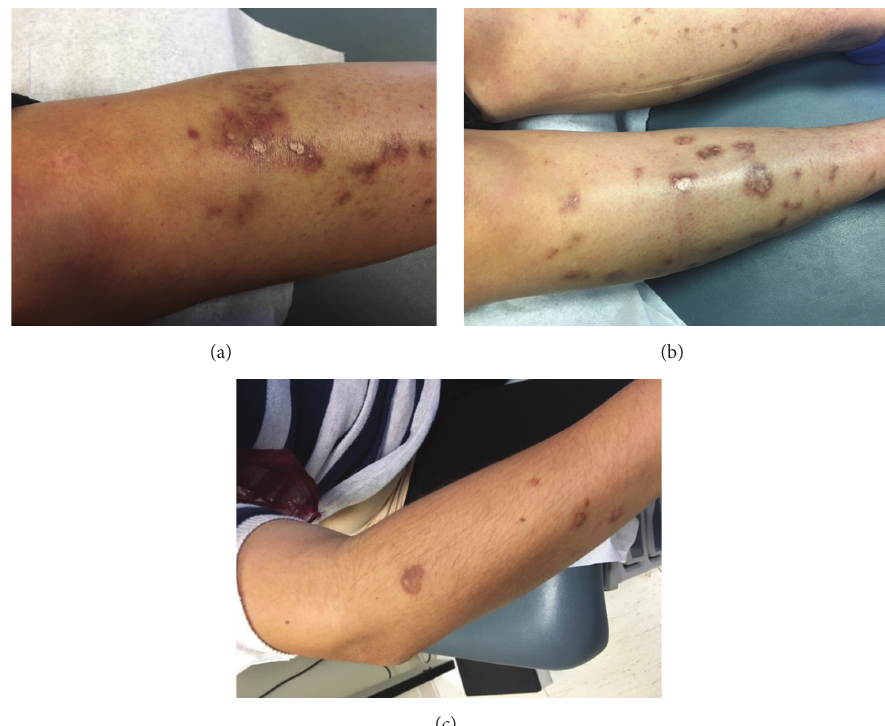
Figure 1: Pictures demonstrating rash in our